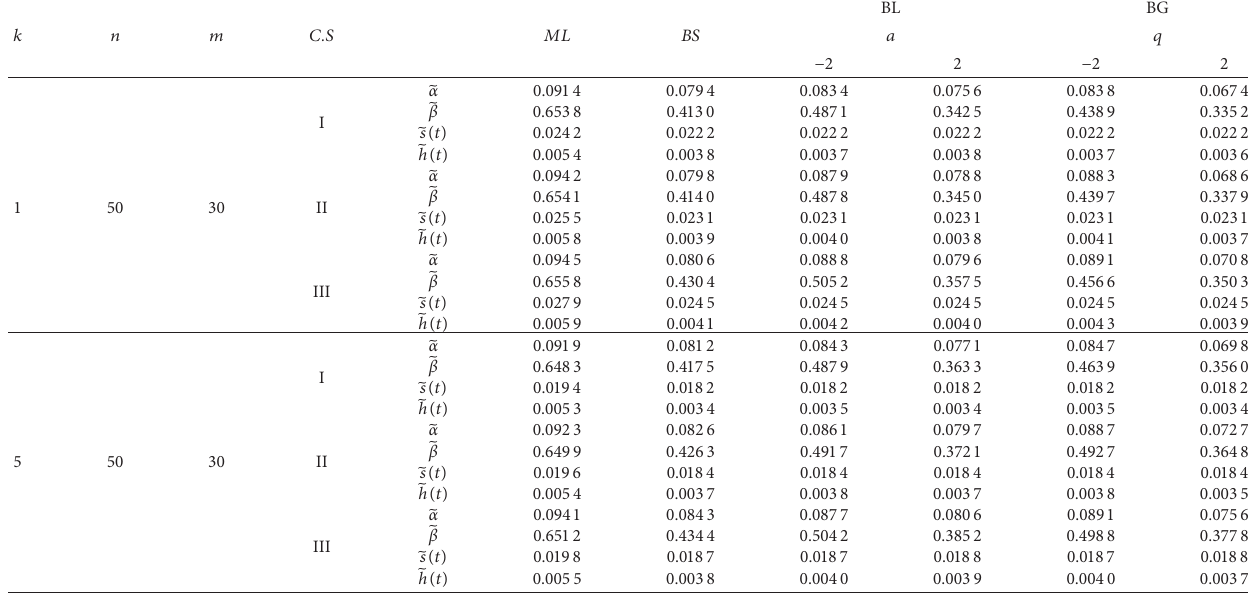
Table 6: MSE of MLEs and BEs with true